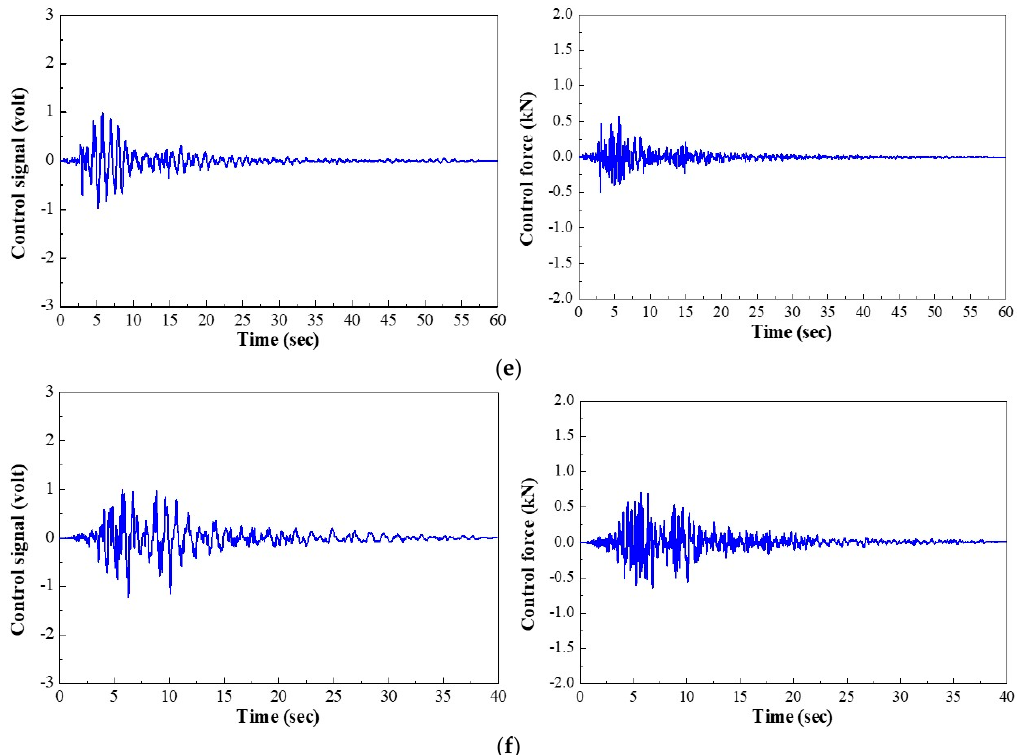
Figure 7. Control signal and control force of the AMD system under the seismic loads: ( a ) California earthquake; ( b ) Northridge earthquake; ( c ) Landers earthquake; ( d ) Cape earthquake; ( e ) San Simeon earthquake; ( f ) Loma Prieta earthquake.